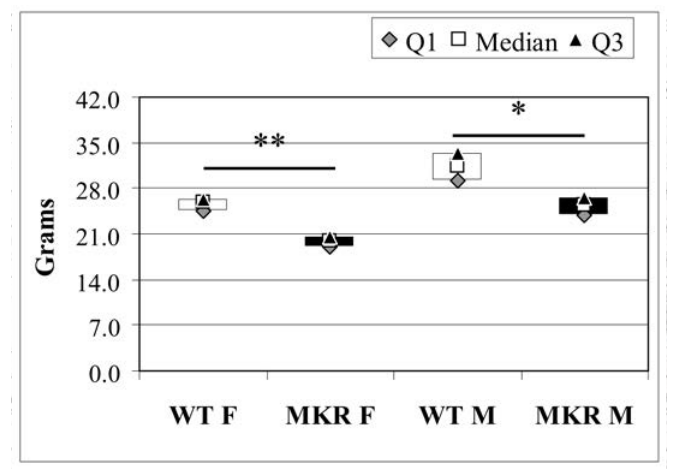
Figure 1. Total body weight of 13-week-old wild-type (WT) and hyperinsulinemic (MKR) mice. Data were expressed as Median (Q1; Q3). F: Female mice; M: Male mice. * Mann-Whitney U -test, p = 3.8 × 10 − 4 ; ** Mann-Whitney U -test p = 2.0 × 10 − 6 .